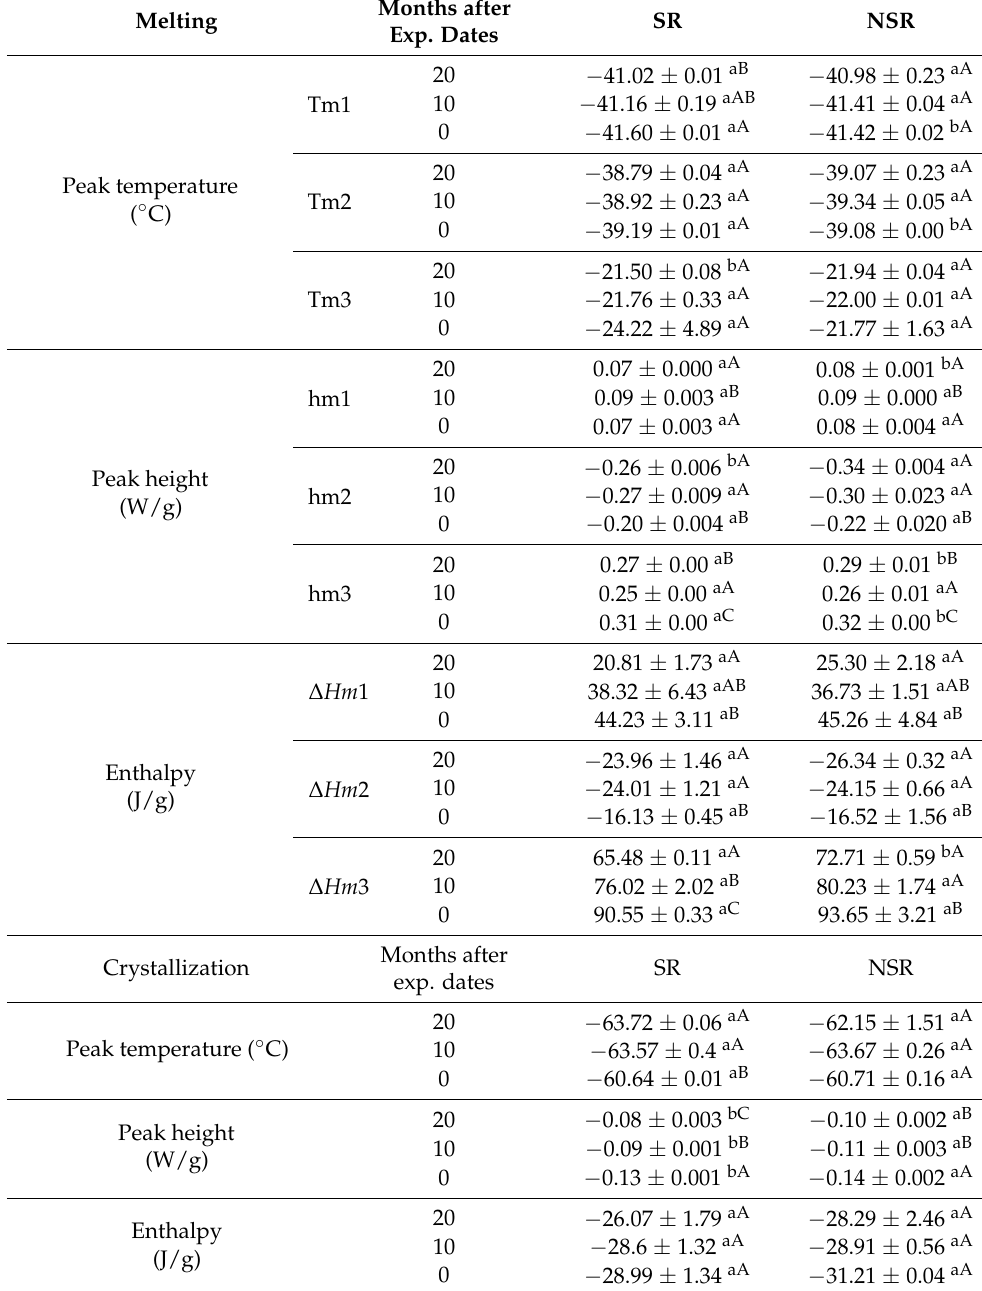
Table 3. DSC melting and crystallization profile of raspberry seed oil at scanning rate 1 ◦